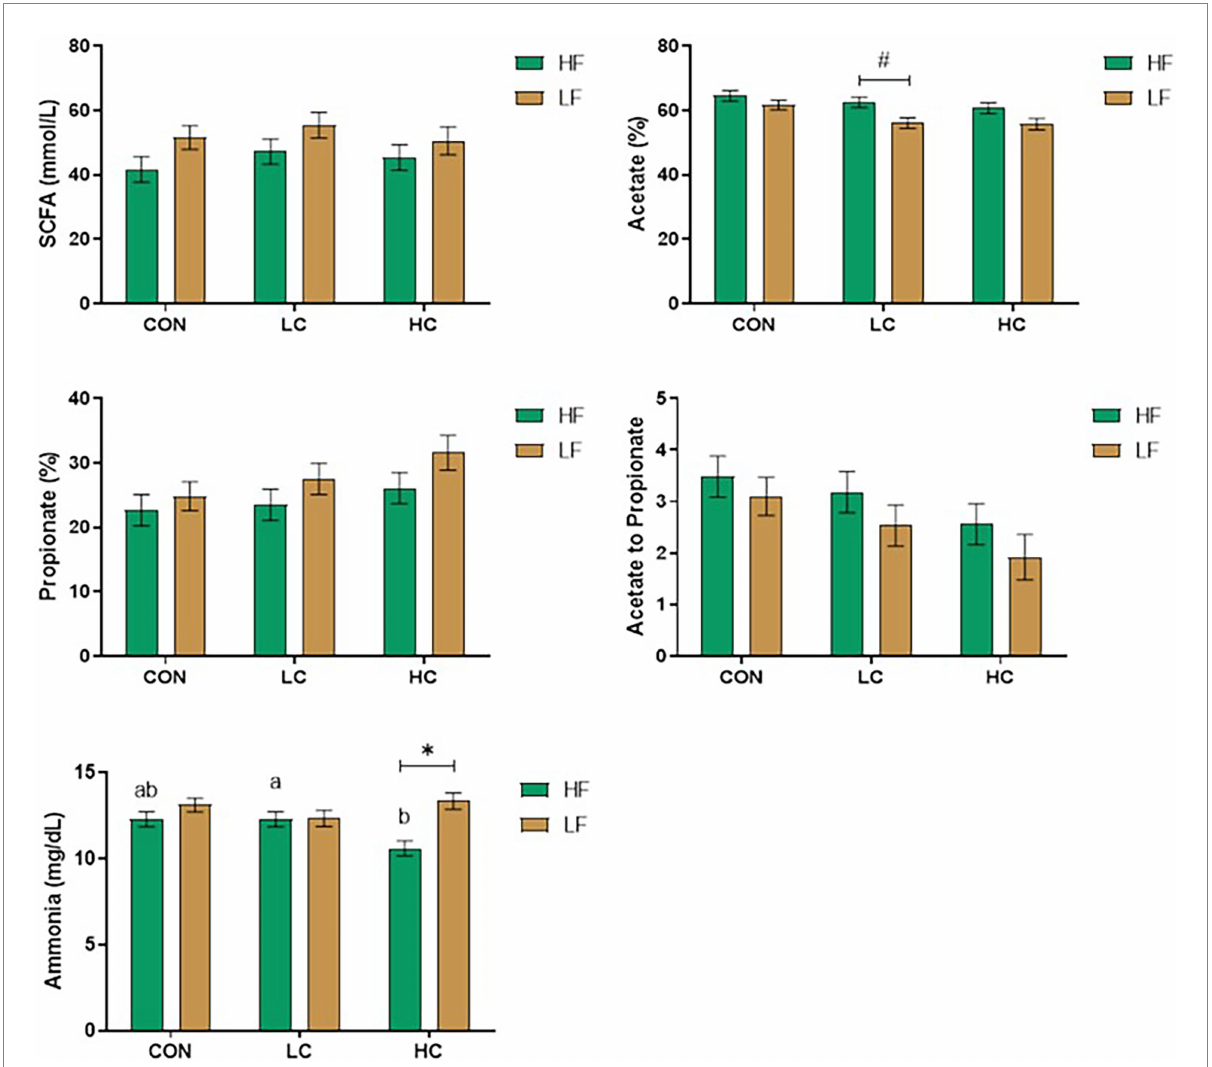
FIGURE 2 Concentrations of short-chain fatty acids (SCFA) and ammonia were affected by capsicum oleoresin (CAP) supplementation and diet. Least- square means of CAP groups within each diet sharing no common letter differ at P ≤ Concentrations. Differences between the dietary conditions within each CAP group ( p ≤ 0.05) ( * ) or 0.05 < p ≤ 0.10 (#). Dietary conditions (forage/concentrate ratio): LF: 30:70; HF: 70:30. CAP levels: CON: 0 mg/L; LC: 20 mg/L; and HC: 200